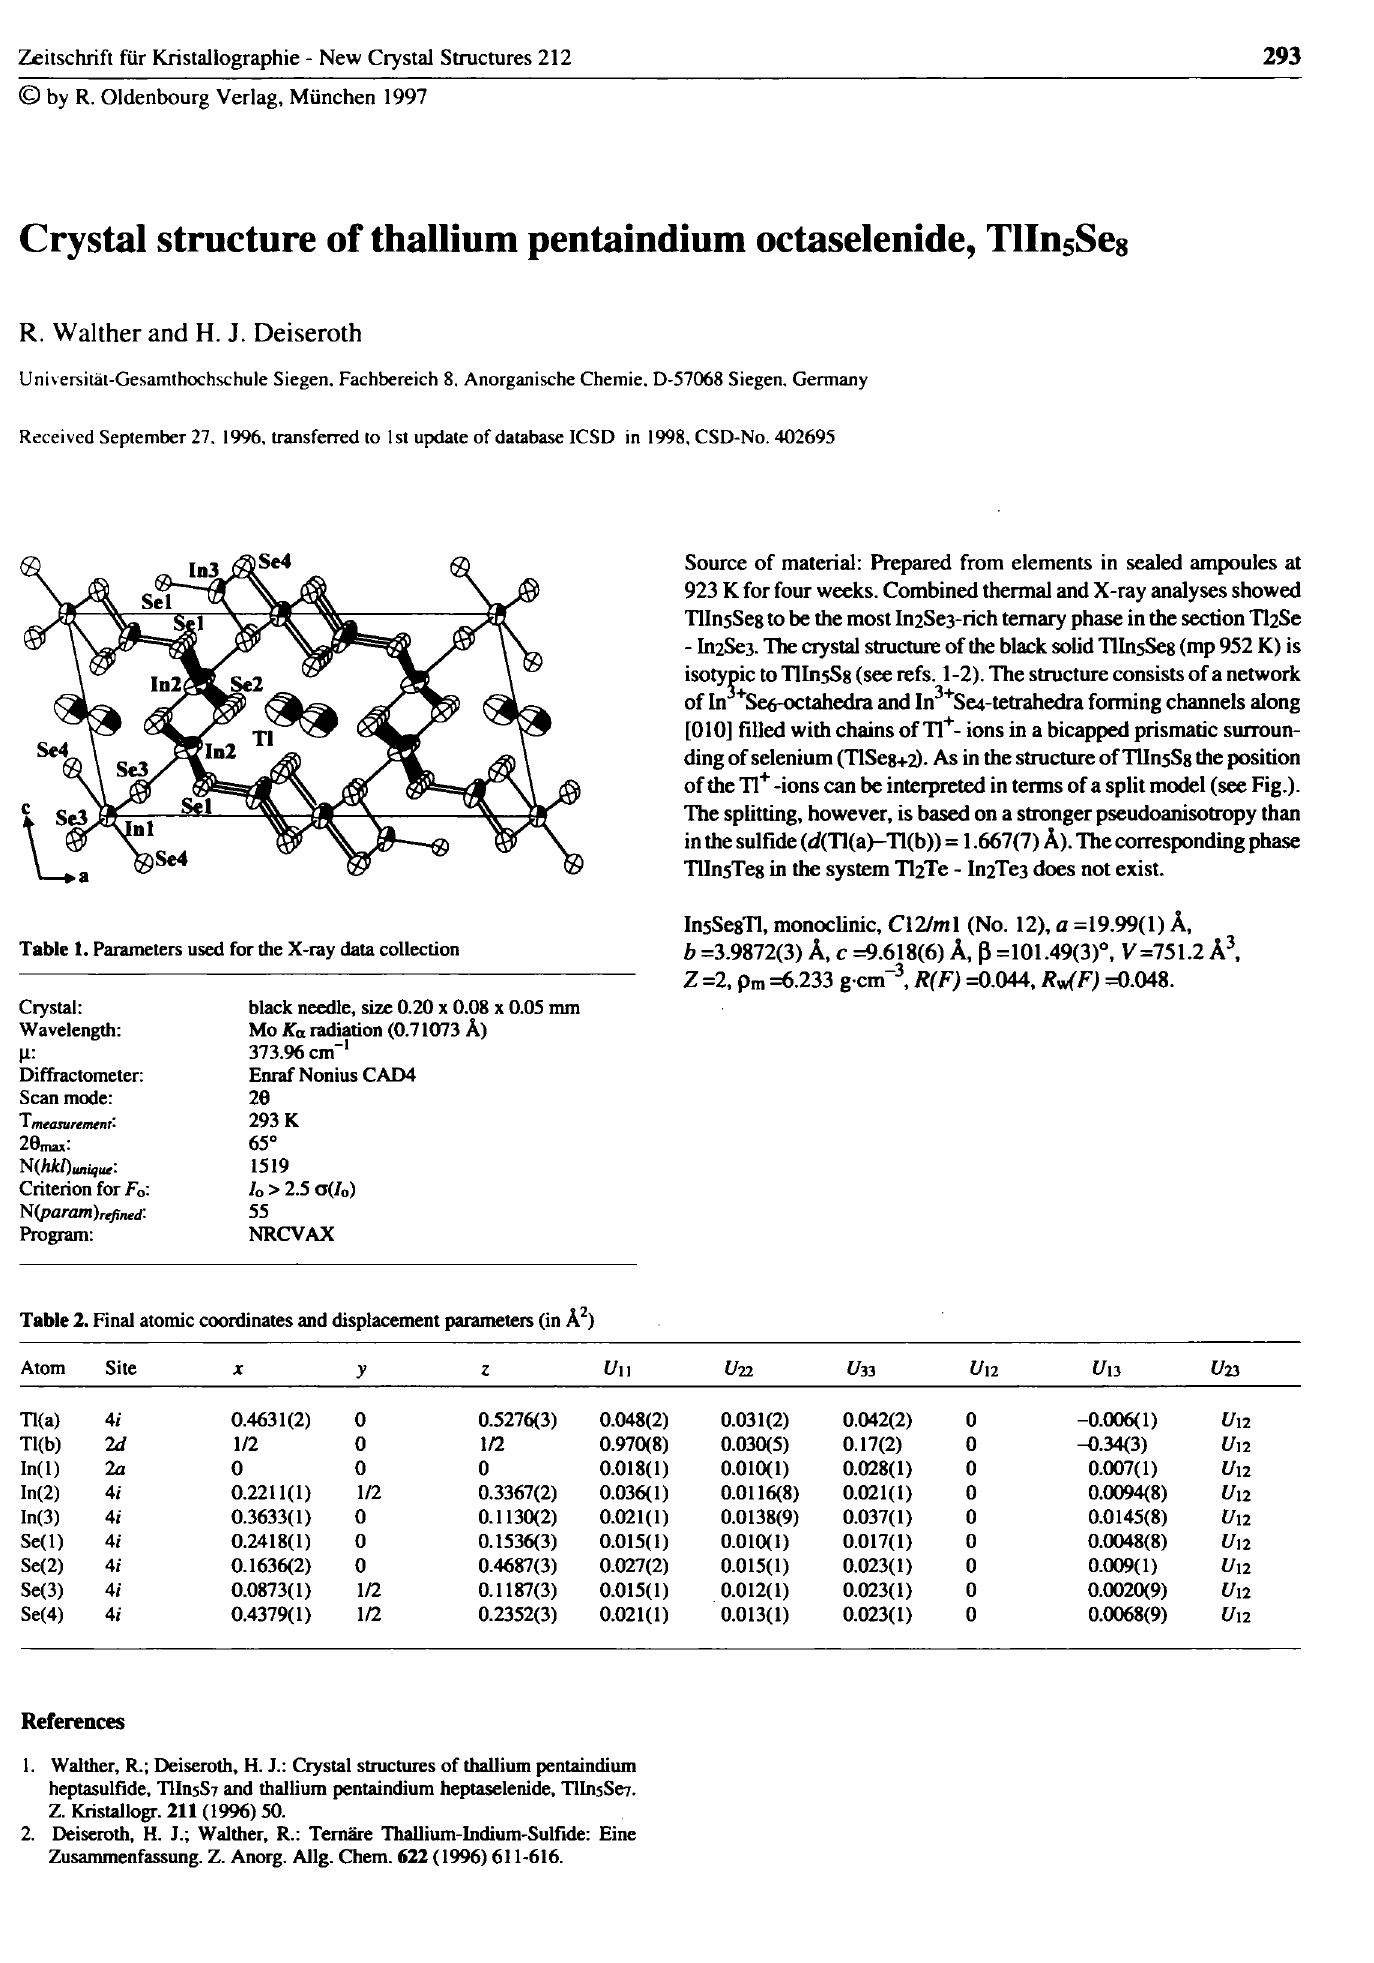
Table 2. Final atomic coordinates and displacement parameters (in Â 2 ) Atom